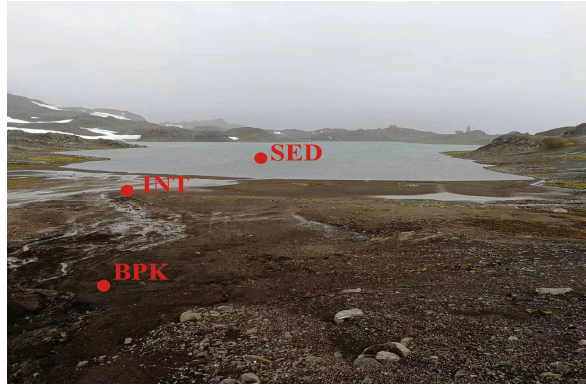
Figure 1. Sampling sites in the Kitezh Lake area.